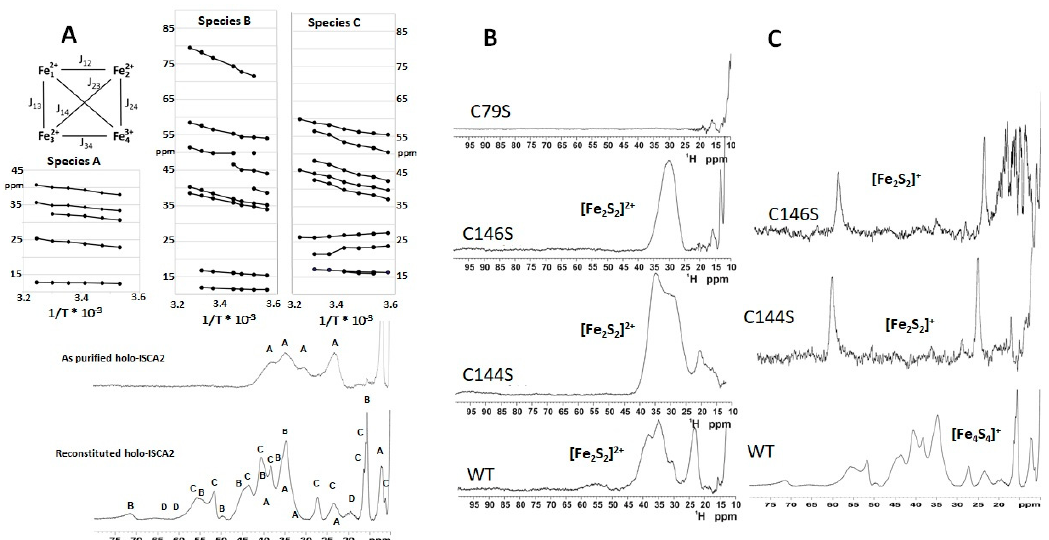
Figure 1. ( A ) Lower part: 1 H NMR spectra of “as purified” holo-ISCA2 and of chemically reconstituted holo-ISCA2 in 50 mM phosphate bu ff er pH 7.0 at 600 MHz and 283 K. Signals labeled A arise from H β and H α from cysteine ligands coordinated to a [Fe 2 S 2 ] 2+ cluster. Signals labeled B, C, and D arise from H β and H α from cysteine ligands coordinated to a [Fe 4 S 4 ] + cluster in different species that have been identi fi ed according to relative intensities of signals B − D observed in di ff erent reconstituted protein samples. Upper part: Temperature dependence of the chemical shifts for the hyperfine-shifted signals of the three different species (A, B, C) of chemically reconstituted holo-ISCA2. Experiments were recorded at 600 MHz, pH 7.0 in the temperature range of 280–308 K. A schematic representation of a [4Fe–4S] cluster and its coupling scheme in the reduced state [Fe 4 S 4 ] + is shown. ( B ) 1 H NMR spectra of chemically reconstituted ISCA2 mutants C79S, C144S, C146S and of wild-type [Fe 2 S 2 ] 2 + –ISCA2 purified from E. coli in 50 mM phosphate buffer pH 7.0 at 600 MHz and 283 K. ( C ) 1 H NMR spectra of the same samples as in panel B, recorded upon addition of a 5mM dithionite as reducing agent. Figure adapted from References [77,78].